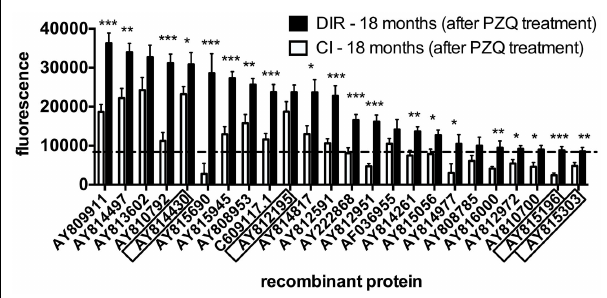
FIGURE 3 | IgG1 antibody profiles to arrayed antigens differ between Schistosoma haematobium -infected humans who do and do not acquire drug-induced resistance after praziquantel treatment . Average adjusted signal intensity values depicting IgG1 antibody responses to each reactive antigen are shown for the drug-induced resistant (DIR) and chronically infected (CI) cohorts after praziquantel treatment. Boxed antigens indicate homologs of known vaccine candidates. The dashed line is the cut-off for IgG1 reactivity (8239), calculated as one standard deviation of the mean of the no-DNA control spots on the array. Statistical analysis was performed using Student’s t -test. * p < 0.05, ** p < 0.01, *** p <